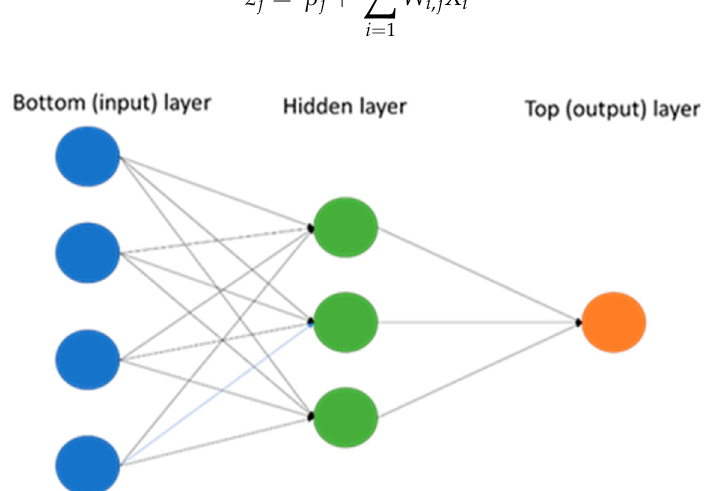
Figure 2. An ANN model with four inputs and one hidden layer with three neurons.